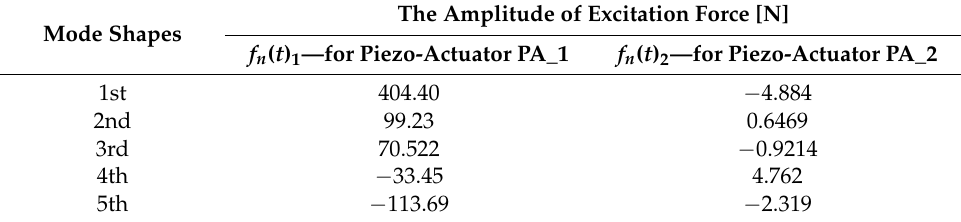
Table 3. Values of the control forces generated by the piezo-actuators PA_1 and PA_2 located on the top surface of the aluminum plate.